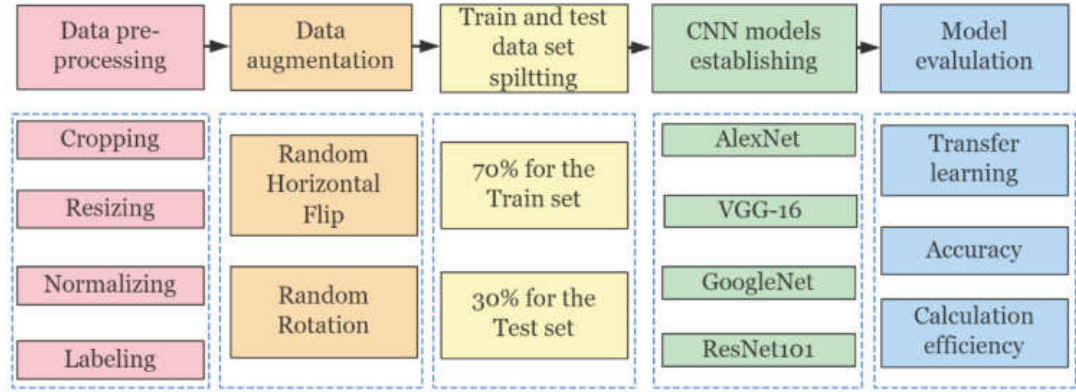
Figure 5. Flow chart of data processing, modeling, and analysis.